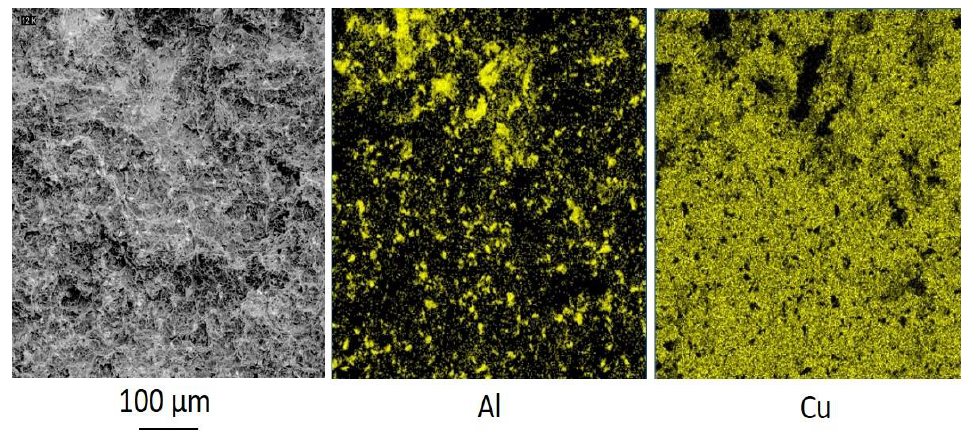
Figure 12. The microstructure and distribution maps of elements of the separation surface on the copper substrate.